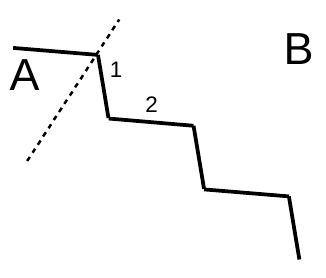
Figure 11 . Simpli(cid:12)ed